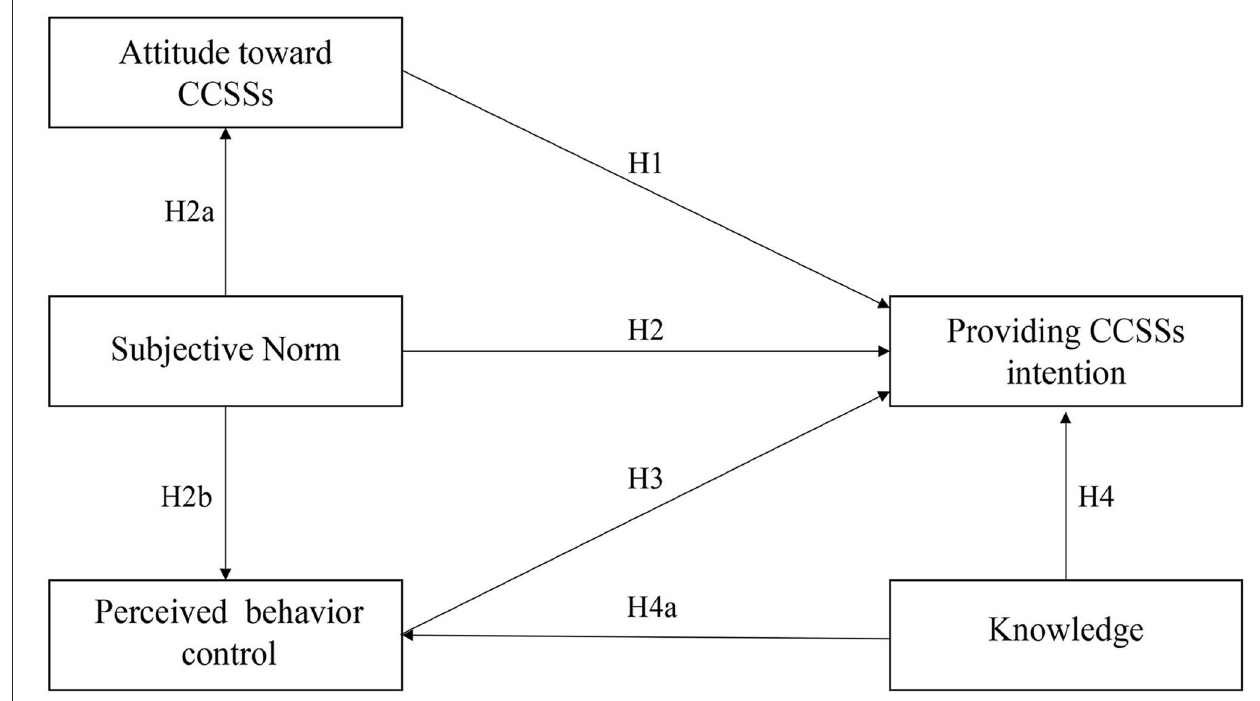
FIGURE 1 | The research model of primary care physicians’ providing CCSSs intention.